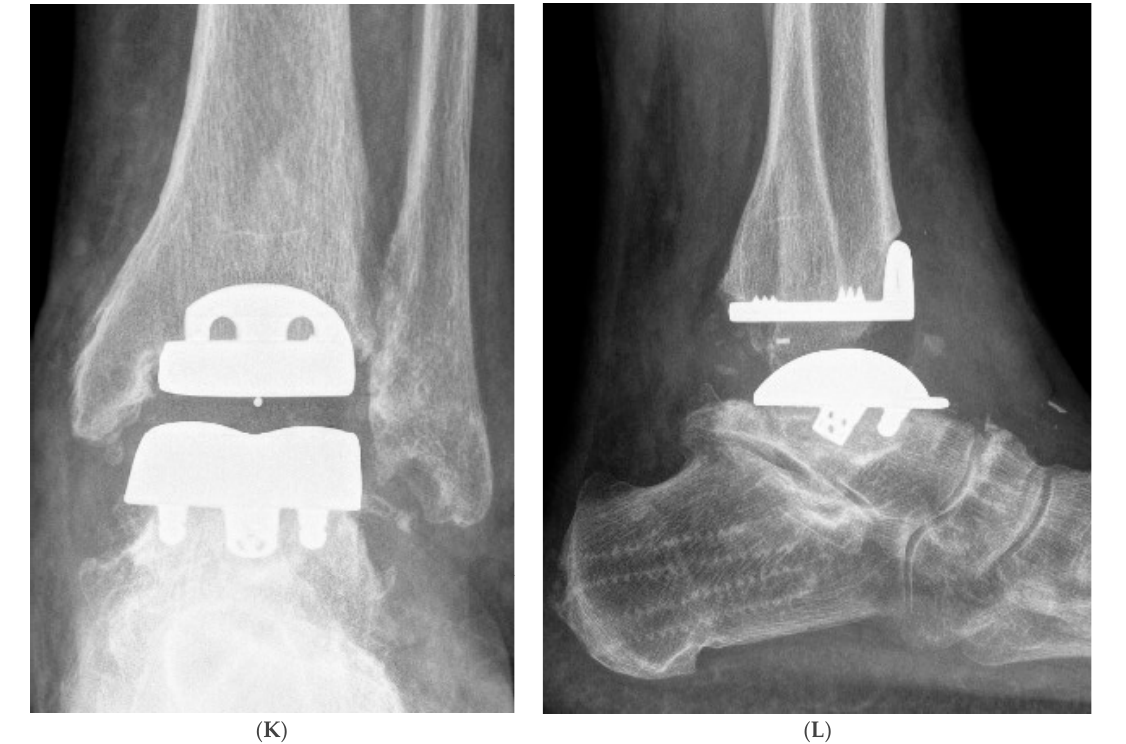
Figure 1. Hybrid Total Ankle Arthroplasty (H-TAA). This figure represents Case Nr. 7 of the cohort (see Tables 1–3). ( A – D ): Preoperative X-rays and CT-scans depicting the cyst under the talar component of the Hintegra TAA. ( E , F ): Intraoperative pictures showing the inlay breakage with poor bone osteointegration in the backside of the talar component of the Hintegra TAA. ( G ): Talar cyst with stable tibial Hintegra component. ( H ): Performance of a flatcut of the talus and bone grafting of the talar cyst with iliac crest autologous spongiosa. ( I ): Flatcut Talar Component of the VANTAGE TAA, which is implanted on the reconstructed talus. ( J ): H-TAA: Tibial component Hintegra TAA with new Flatcut Talus and Inlay of VANTAGE TAA. ( K , L ): Postoperative X-rays with H-TAA, good talar bone reconstruction, and good integration of the Flatcut Talus of VANTAGE TAA. Follow-Up Table 3. Results of Hybrid Total Ankle Arthroplasty